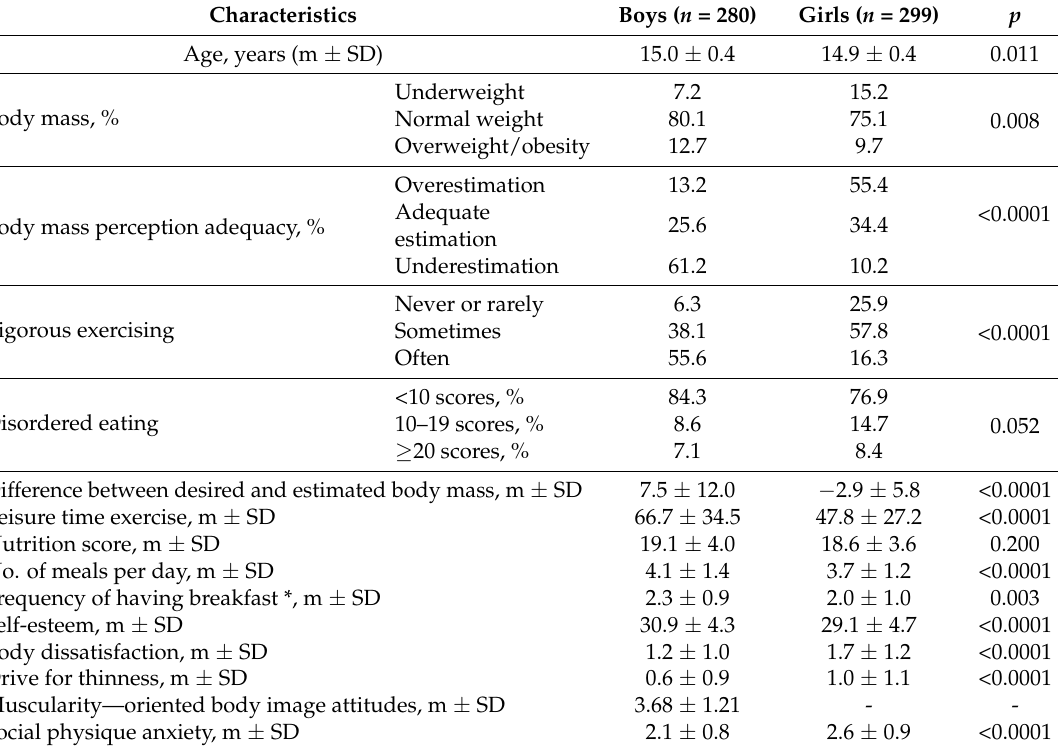
Table 1. Descriptive statistics for the sample ( n = 579).